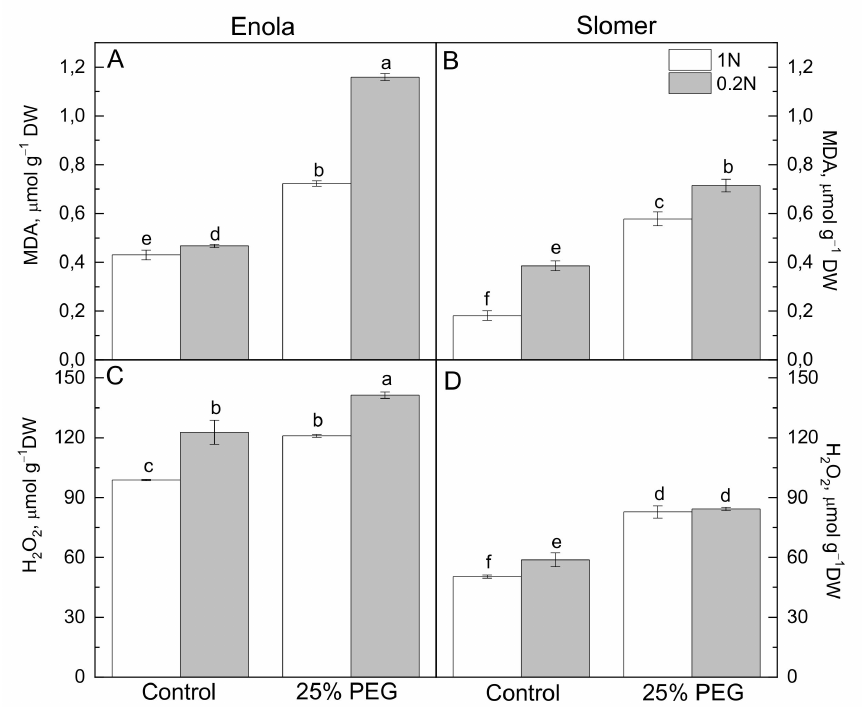
Figure 3. Amounts of MDA ( A , B ) and H 2 O 2 ( C , D ) in leaves of two wheat varieties (Enola and Slomer) grown with optimal (1 N) and reduced (0.2 N) nitrogen supply and subjected to osmotic stress with 25% PEG. Different letters represent significant differences at p < 0.05 ( n =